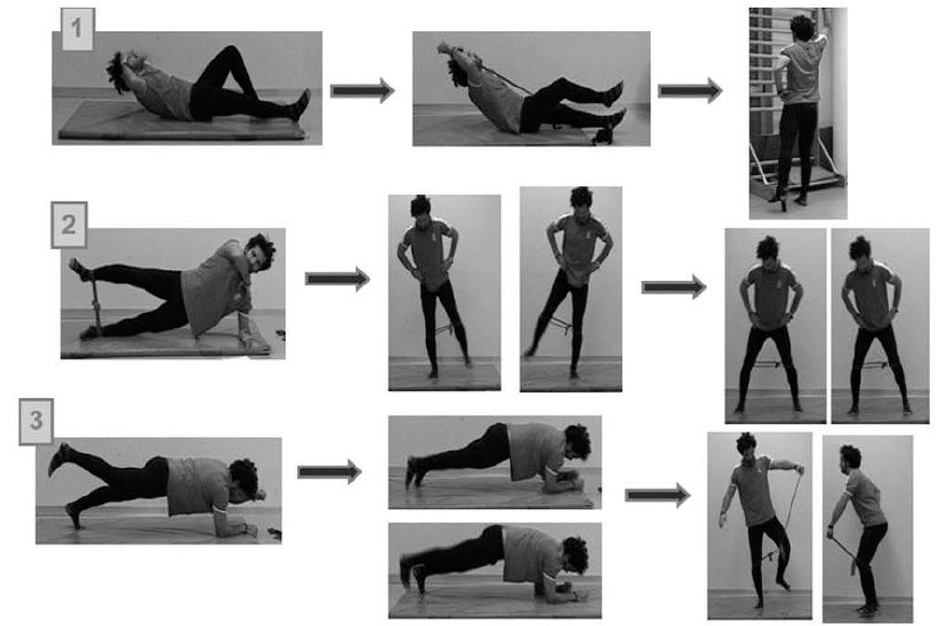
Figure 2. Core stability training program divided into 3 different training phases. The first column of the figure represents the 3 core exercises. The second and third columns exemplify the progression of each exercise, adding motor control difficulty, in ascending order.